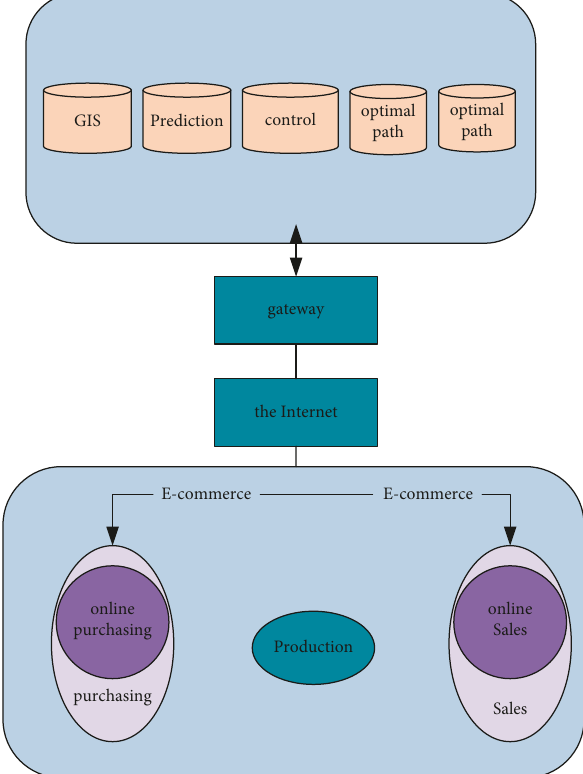
Figure 3: Schematic diagram of the system structure for the co- ordinated development of urban ITS and